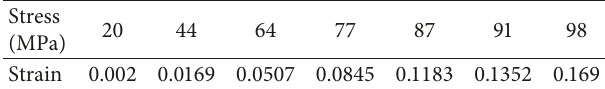
Table 2: Stress-strain properties of 1060 aluminum